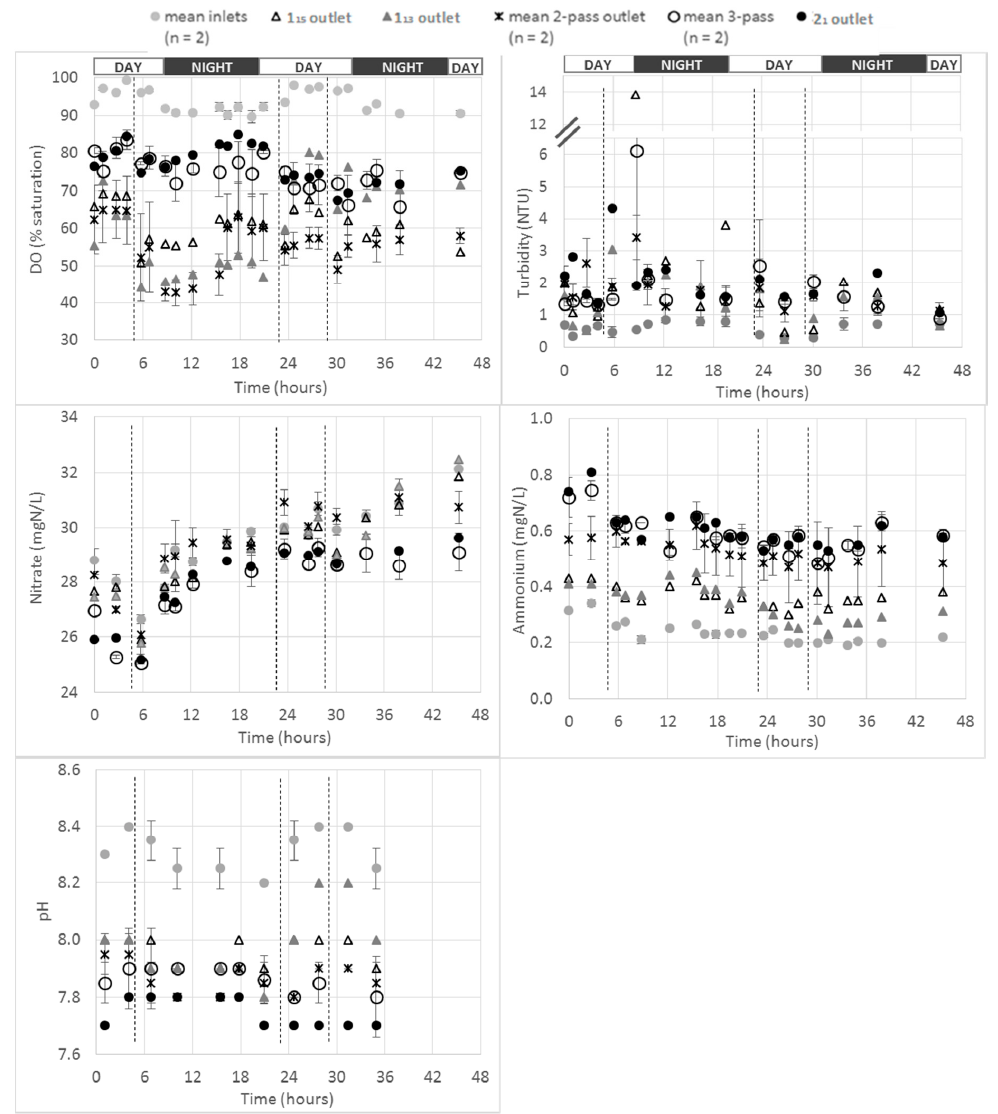
Figure 2. Average evolution of water quality (i.e., dissolved oxygen saturation rate, turbidity, nitrate, ammonium and pH) at the farm inlets and in “1-pass”, “2-pass”, “3-pass” and 2 1 ponds outlets. Vertical dash lines represent feeding times.